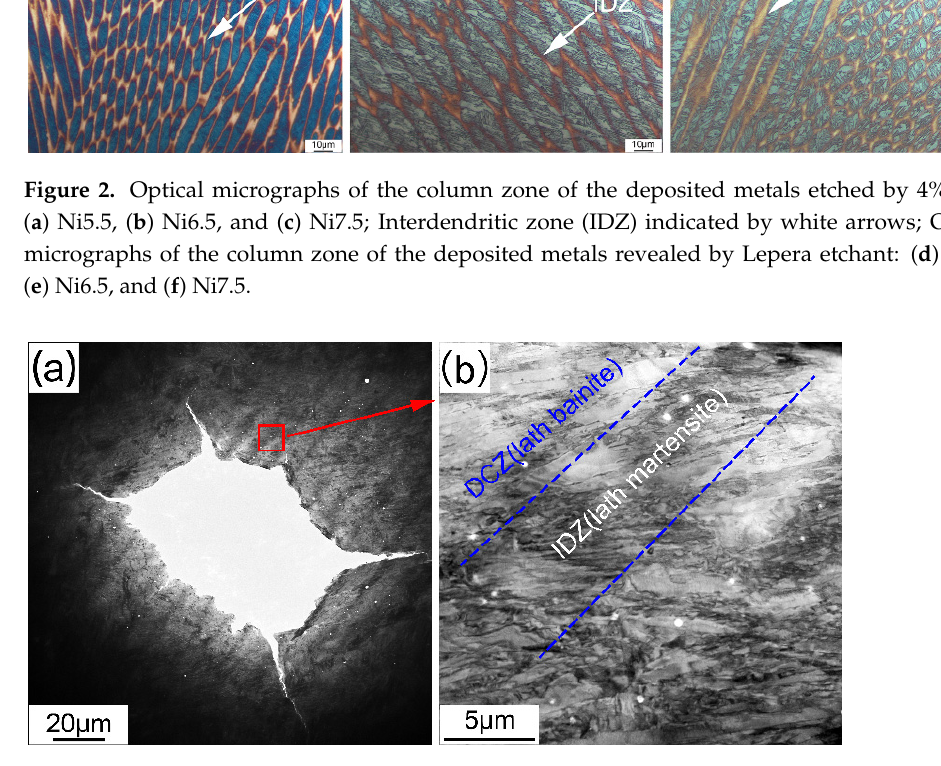
Figure 2. Optical micrographs of the column zone of the deposited metals etched by 4% nital: ( a ) Ni5.5, ( b ) Ni6.5, and ( c ) Ni7.5; Interdendritic zone (IDZ) indicated by white arrows; Optical micro- graphs of the column zone of the deposited metals revealed by Lepera etchant: ( d ) Ni5.5, ( e ) Ni6.5, and ( f ) Ni7.5.